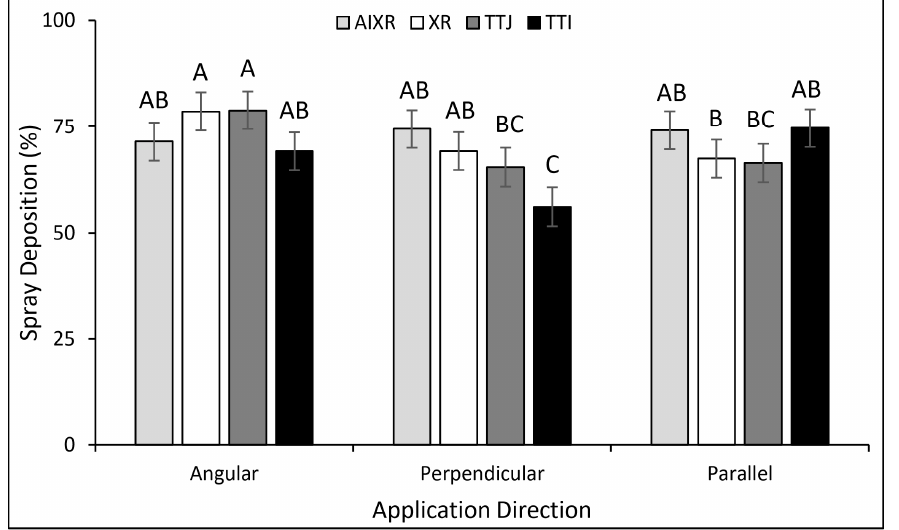
Figure 1. The interaction of nozzle type and application direction of travel on herbicide spray deposition near the soil surface when applied in wheat stubble. Error bars indicate the standard errors of the mean. Letters indicate significant differences ( α = 0.05) using Tukey’s studentized range test.